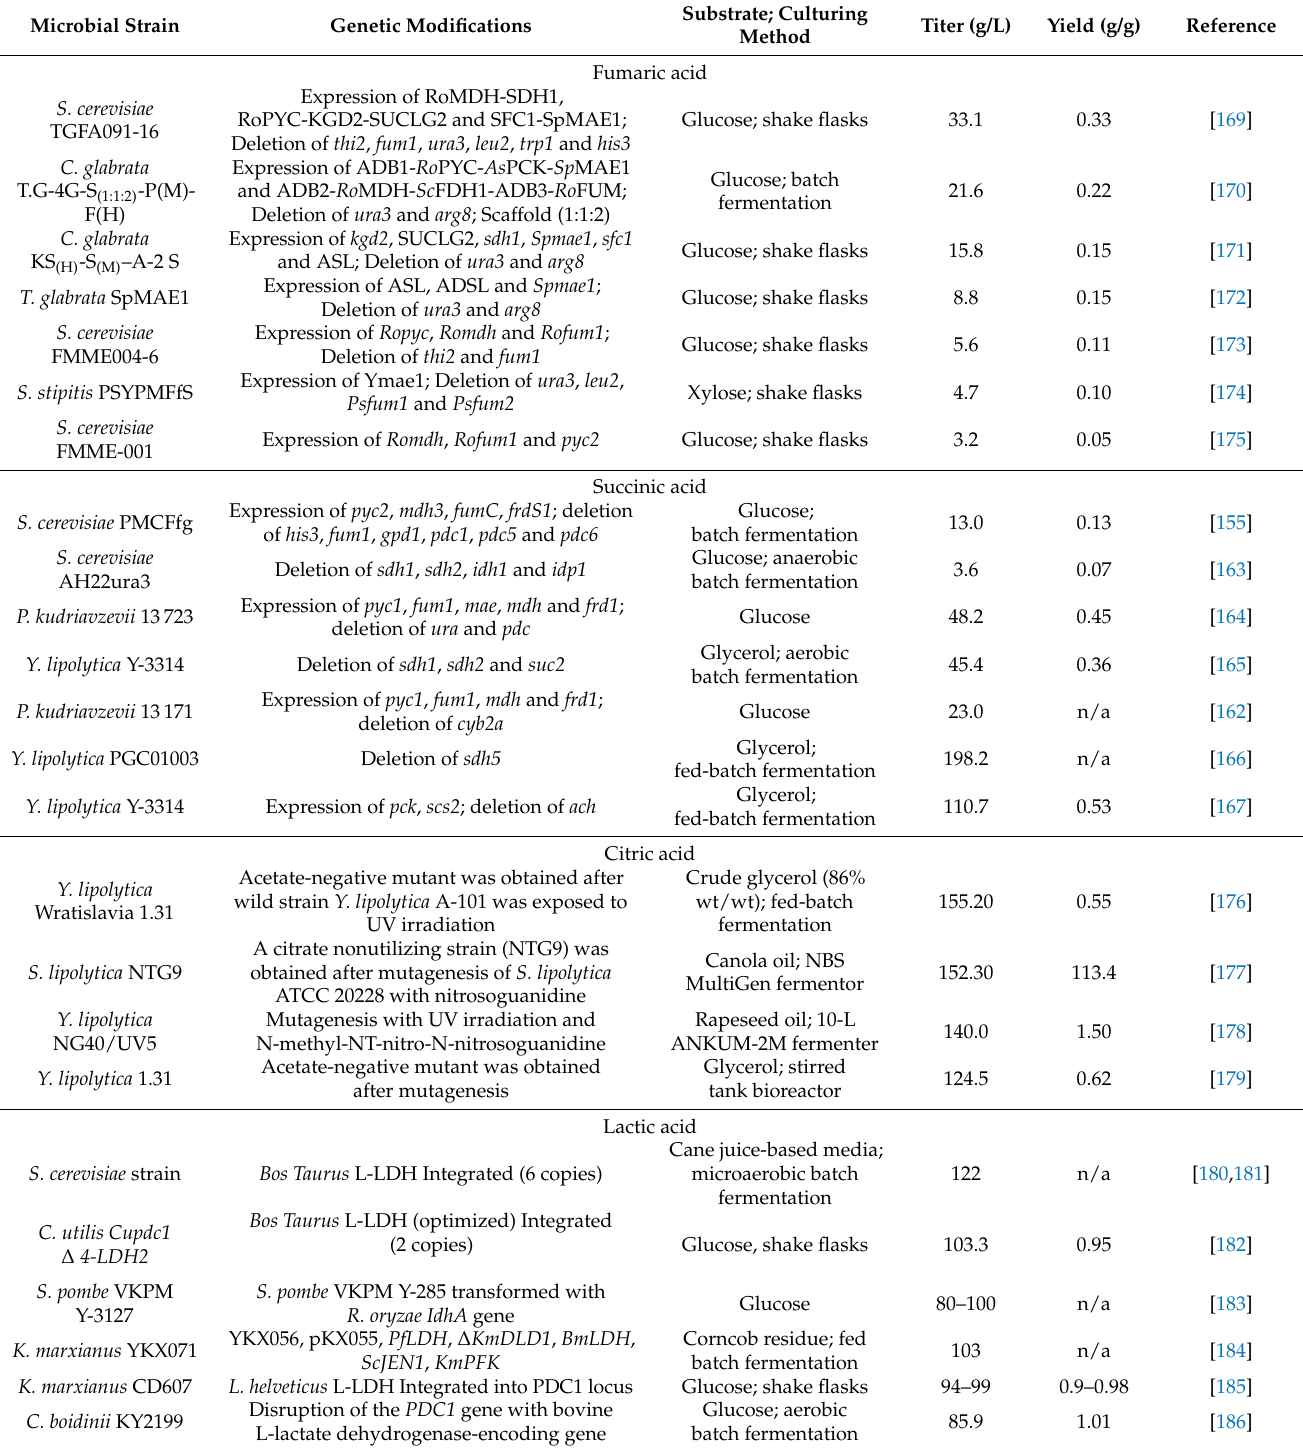
Table 6. Yeast strains modified for organic acid production (adapted from [133,159,162,168].) Microbial